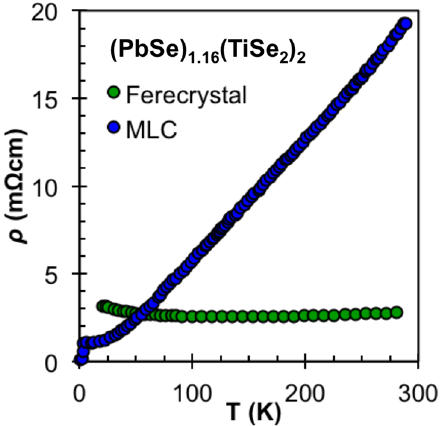
Figure 8. MLC [65] and ferecrystal (from set A in this work) temperature dependent in-plane resistivities. The turbostratically disordered compound is found to be almost temperature independent due to the disruption of phonons in the out of plane